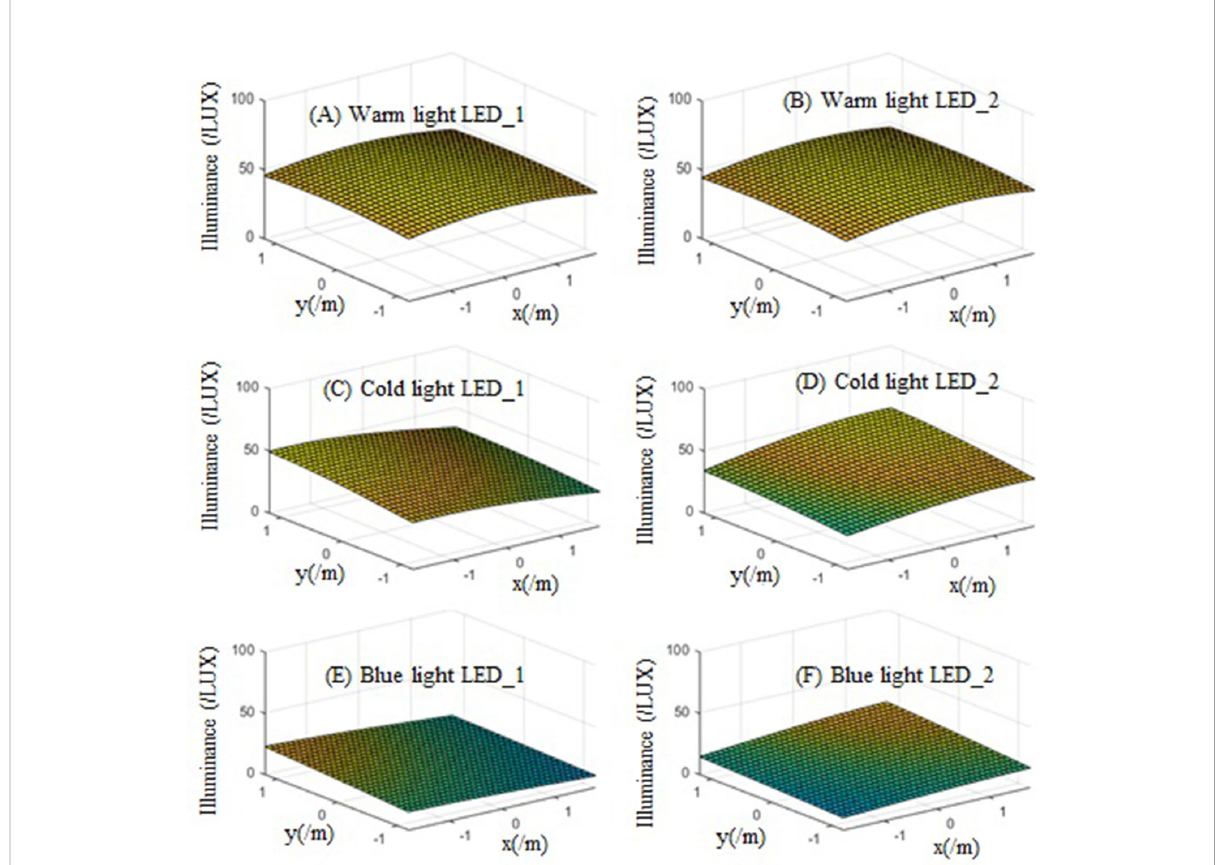
FIGURE 6 The illumination distribution of each single LED lamp with a distance of 6m: (A) the illumination distribution of warm-light LED_1 on target surface; (B) the illumination distribution of warm-light LED_2 on target surface; (C) the illumination distribution of cold-light LED_1 on target surface; (D) the illumination distribution of cold-light LED_2 on target surface; (E) the illumination distribution of blue-light LED_1 on target surface; (F) the illumination distribution of blue-light LED_2 on target surface.